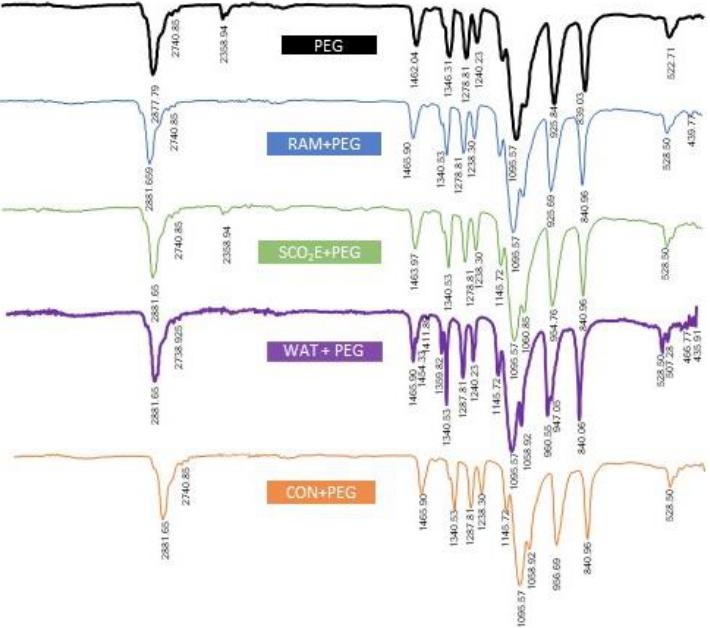
Figure 3. FTIR spectra of the algae pigment microparticles obtained by the PGSS process (RAM+PEG — raw algal material, SCO 2 E+PEG — extract obtained with supercritical extraction, CON+PEG — dry extract obtained with conventional extraction, WAT+PEG — dry extract obtained with ethanol/water extraction, PEG — polyethylene glycol). The absorption characteristics of PEG in the algae pigment microparticles processed by PGSS were represented from 4000 to 520 cm − 1 (Figure 3). The carrier’s (PEG 4000) spec- trum bands were visible at 2881.65 cm −1 due to -C-H stretching vibrations, and at 1465 and 1340 cm −1 due to -C-H vibrations. Two bands at 1278 –1058 cm −1 were due to the stretching vibrations of the alcoholic -O-H and -C-O-C ether linkages [22]. In the comparison of PEG and microparticles, the band at 950 cm −1 of the microparticle showed a considerable con- tribution of algae extract in the microparticles. The band is assignable to the C=C, a trans- substituted functional group that is characteristic of brown macroalgae [23]. These find- ings allowed us to confirm that SCO 2 extract was well encapsulated in PEG 4000. How- ever, FTIR spectra of PEG and microparticles prepared by the PGSS technique were very similar, demonstrating that the PEG’s chemical structure was not changed by the PGSS processing. 3.3. Morphology of algal pigment microparticles Processing of pigment extract with the PGSS process resulted in porous particles of varied shapes and of a smaller particle size (Figure 4; b,c,d) compared to the original ma- terial (Figure 4, a). The solidification of the material after depressurization and the release of CO 2 from the substance caused an open and porous structure of microparticles [24]. Other encapsulation processes, such as spray drying, also show the non-sphericity of mi- croparticles, and this morphology can affect the way active compound is released since it has shorter active compound diffusion paths [25,26].